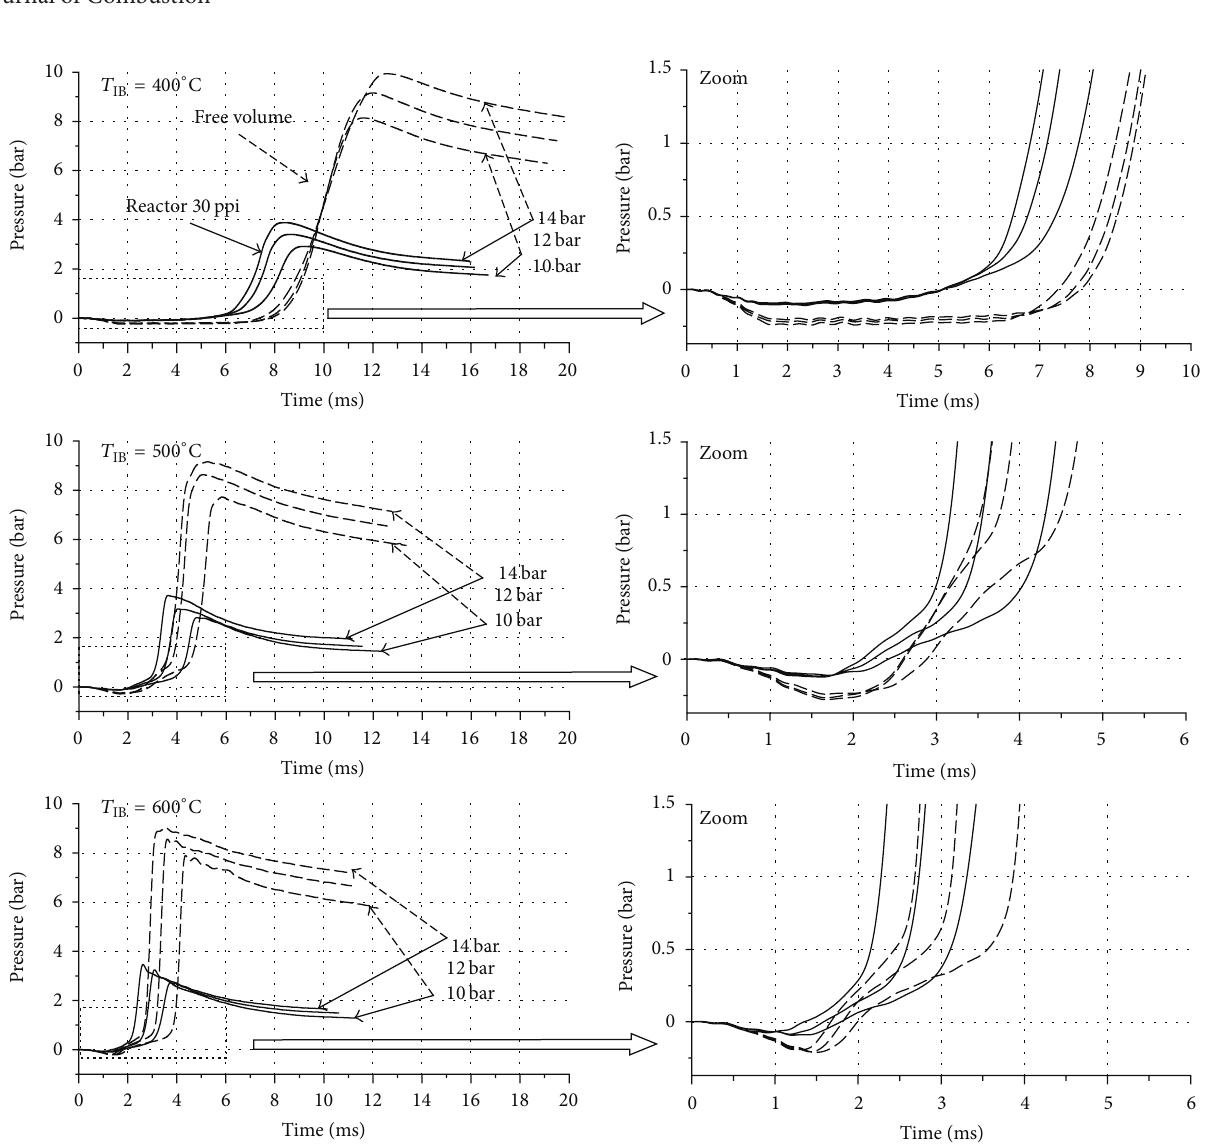
= 10bar, 12bar and 14bar. The amount IB